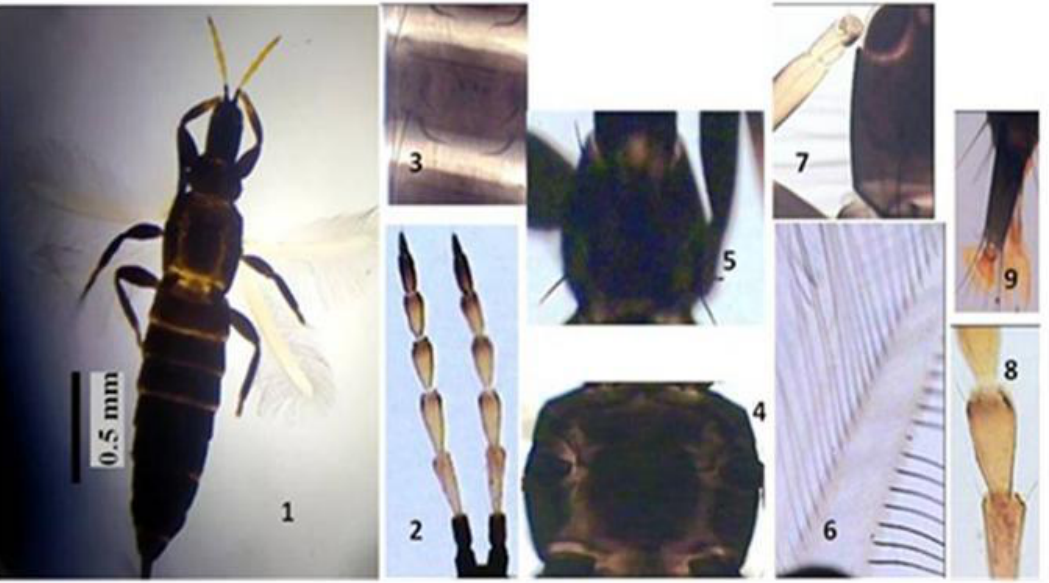
Figure 1. 1, Liothrips oleae female: 2, antenna; 3, abdominal tergites; 4, mesonotum and metanotum; 5, pronotum; 6, wing; 7, head; 8, antennal segments III–IV; 9, segments IX–X.